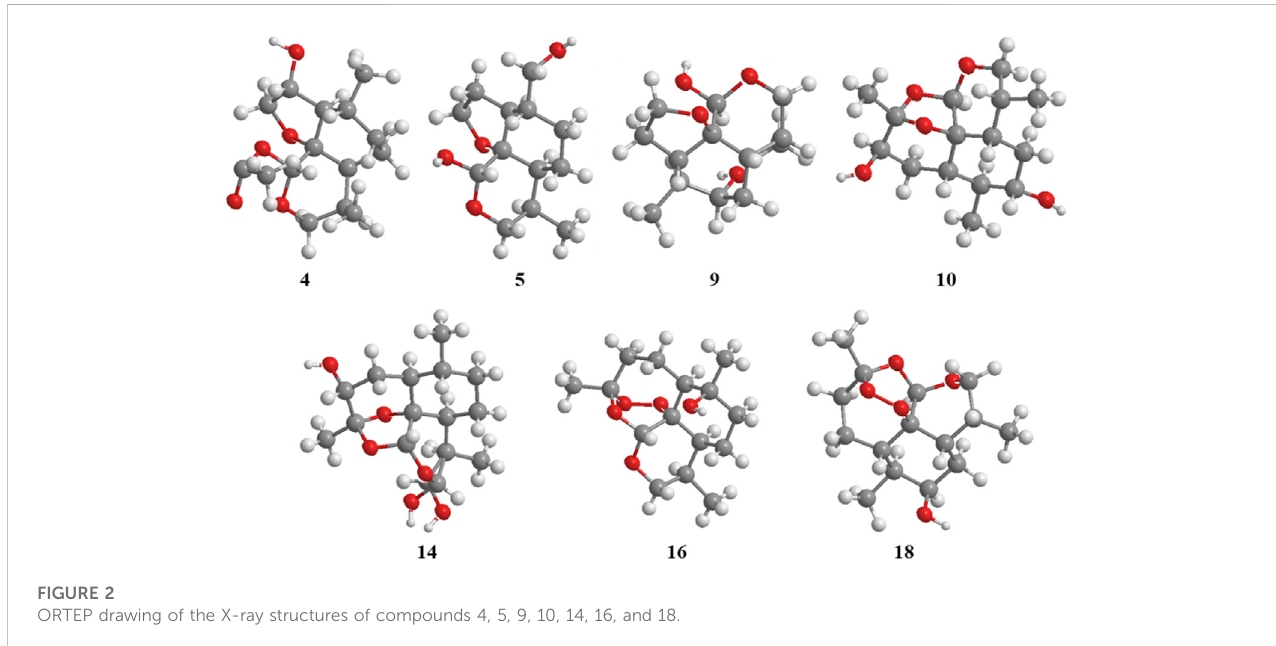
FIGURE 2 ORTEP drawing of the X-ray structures of compounds 4, 5, 9, 10, 14, 16, and